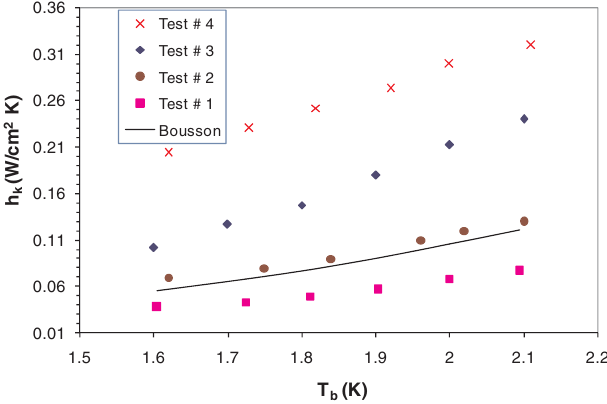
FIG. 16. (Color) Kapitza conductance increase history for sam- ple S2 through all the processes especially after titanification (test #4).